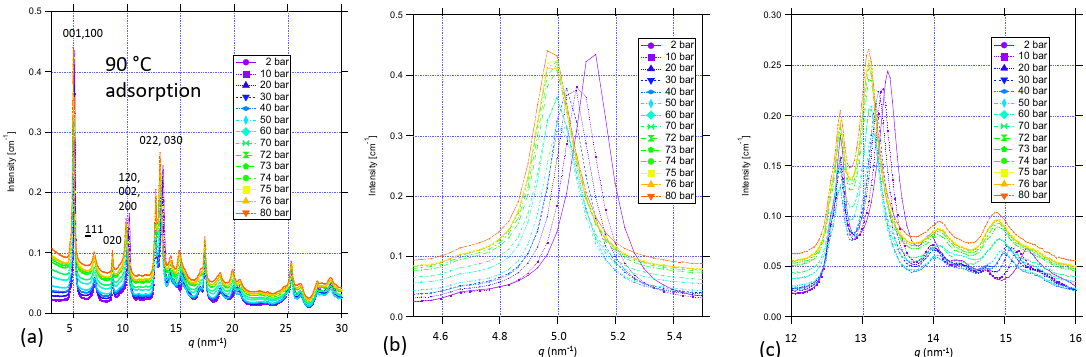
Figure 4. Combined SAXS/WAXS XRD patterns for ( a ) NiBpene during CO 2 adsorption to 80 bar in the supercritical fluid regime; ( b ) expanded plot of Bpene linker XRD peak at q ≈ 5 nm − 1 ; and ( c ) expanded plot of XRD peak at q ≈ 13 nm − 1 . Uncertainties represented by (small) scatter within each dataset.